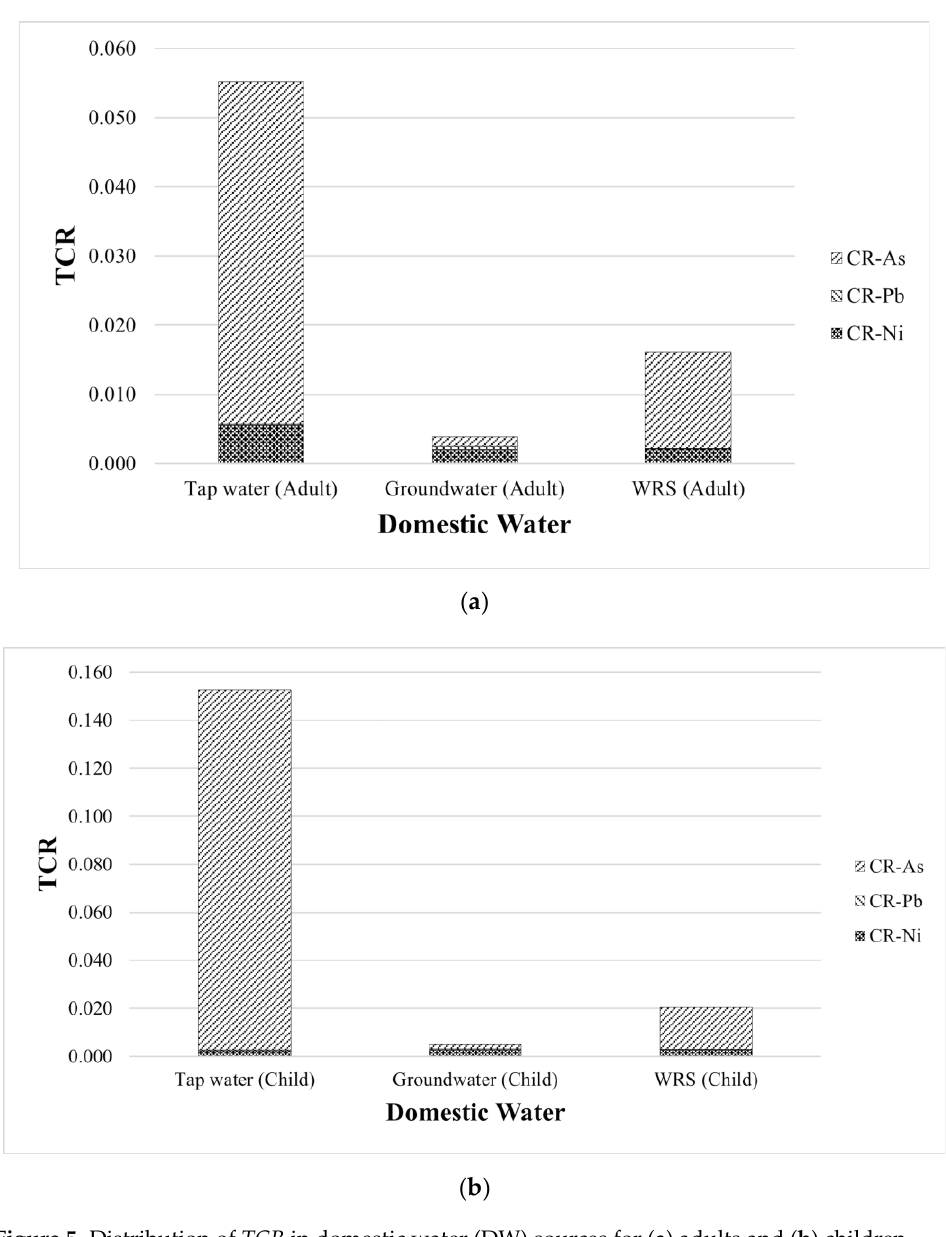
Figure 5. Distribution of TCR in domestic water (DW) sources for ( a ) adults and ( b ) children.